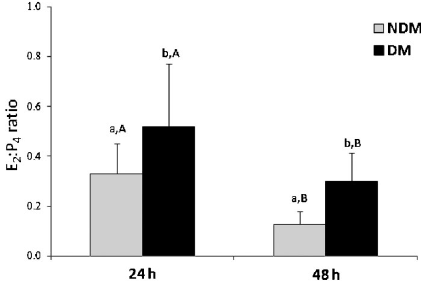
Figure 2. E 2 :P 4 ratio of nondefined medium (NDM) and defined medium (DM) after 24 and 48 h of culture. a,b Significant differences between NDM and DM ( t -test, P , 0.05). A,B Significant differences between data obtained at 24 and 48 h in NDM or DM (one-way ANOVA, P , 0.05). Two-way ANOVA indicated no significant differences between groups (P=0.27).